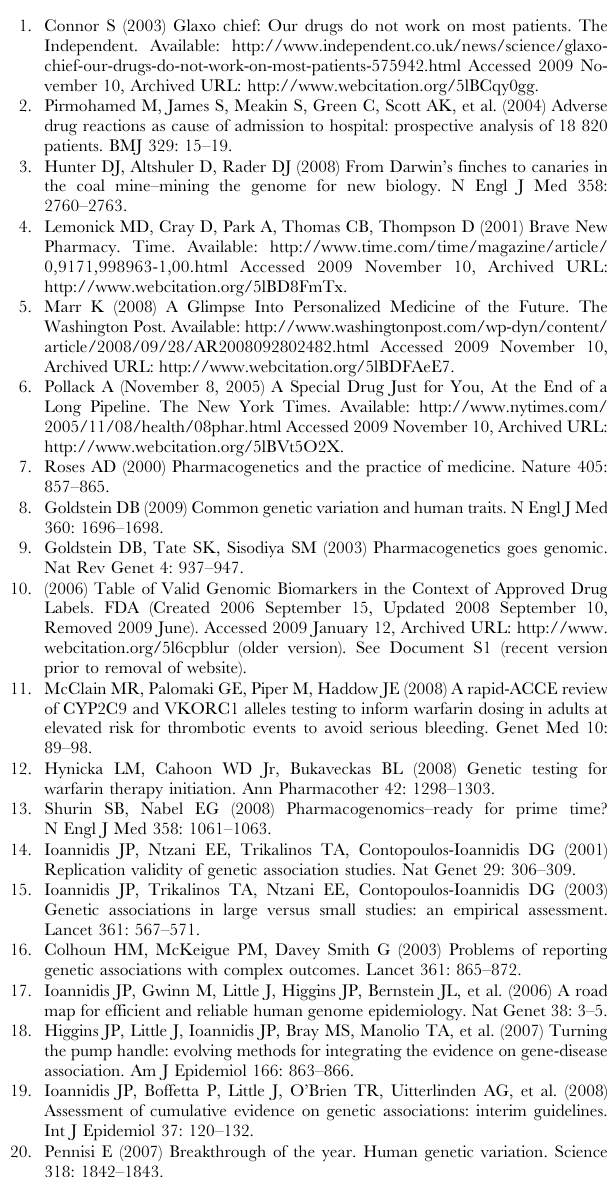
Table S1 U.S. Food and Drug Administration (FDA)